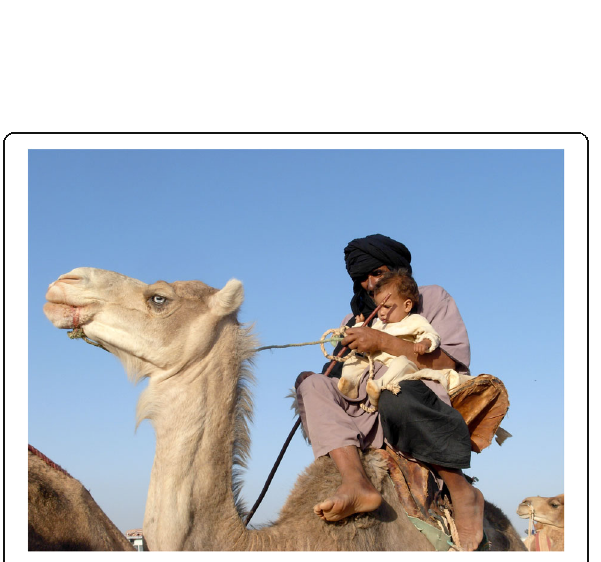
Figure 7 Male riding camel of Annafi breed from Eastern Sudan with solid coat and extremely pale iris (Dioli